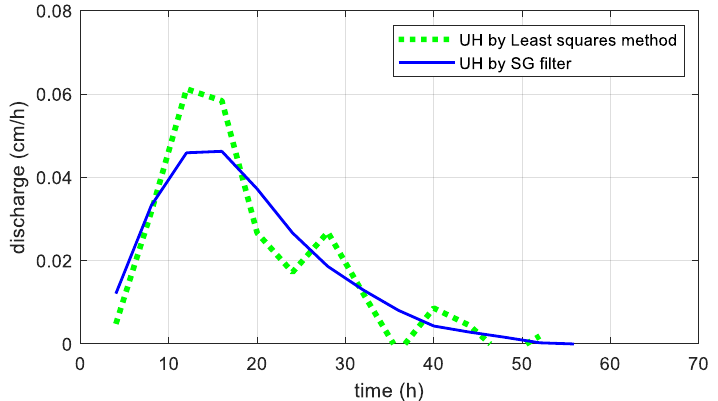
Figure 8. Comparison of UHs before and after the application of the SG filter (in North Potomac River near Cumberland watershed).